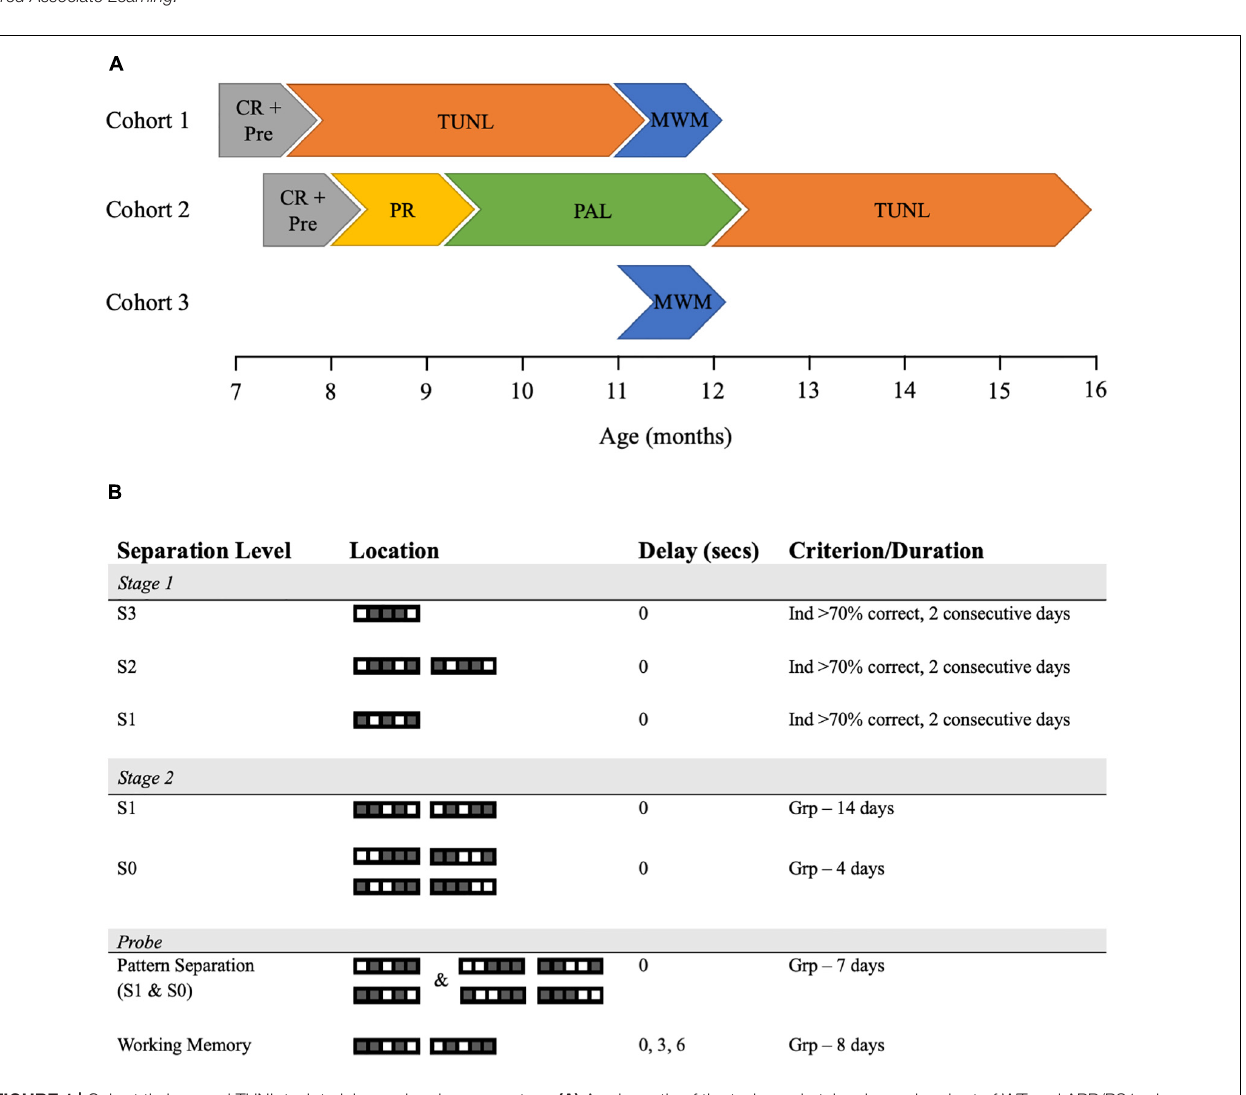
FIGURE 1 | Cohort timings and TUNL task training and probe parameters. (A) A schematic of the tasks undertaken by each cohort of WT and APP/PS1 mice. (B) TUNL training and probes were presented in the order they were performed, with samples of the trials seen during each stage of the task displayed. Each trial is shown in the choice phase, thus one square would be the incorrect, previously displayed stimuli while the other would be the correct, newly displayed stimuli. CR, Caloric Restriction; Pre, Pre-training; TUNL, Trial Unique Non-matching to Location; MWM, Morris Water Maze; PR, Progressive Ratio; PAL, Paired Associate Learning; Ind, Individual animal; Grp,